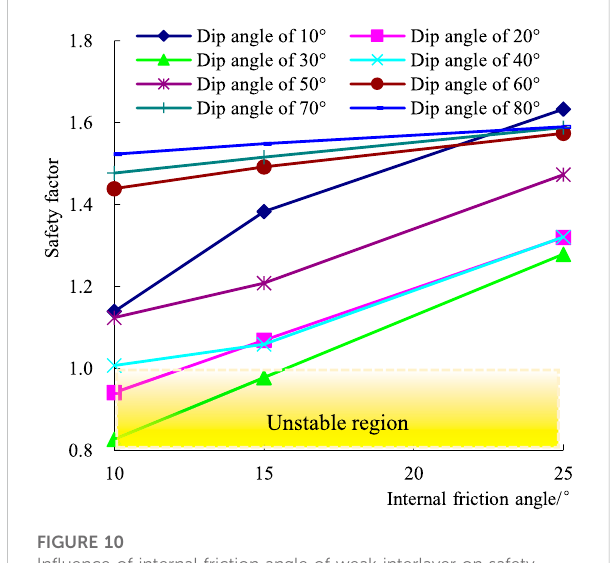
FIGURE 11 In fl uenceofdipangleofrockstratumonsafetyfactoratdifferent slope angle.